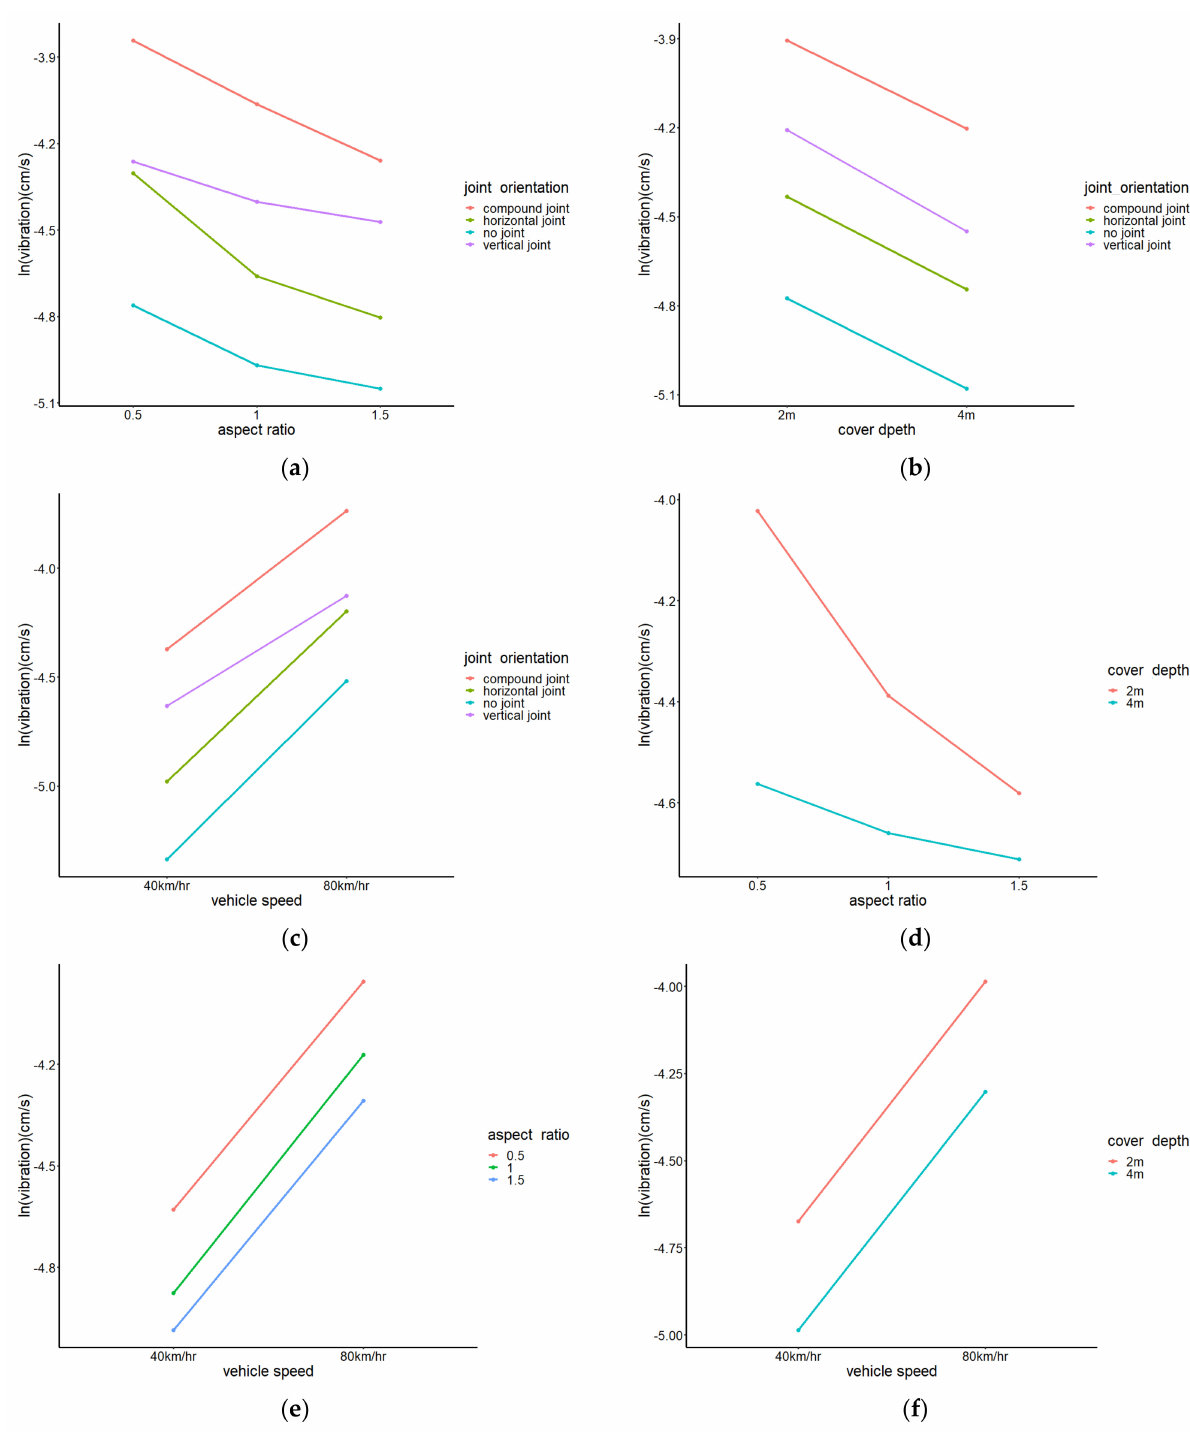
Figure 6. Interaction plots between two factors. ( a ) Joint orientation and aspect ratio; ( b ) Joint orientation and cover depth; ( c ) Joint orientation and vehicle speed; ( d ) Aspect ratio and cover depth; ( e ) Aspect ratio and vehicle speed; ( f ) Cover depth and vehicle